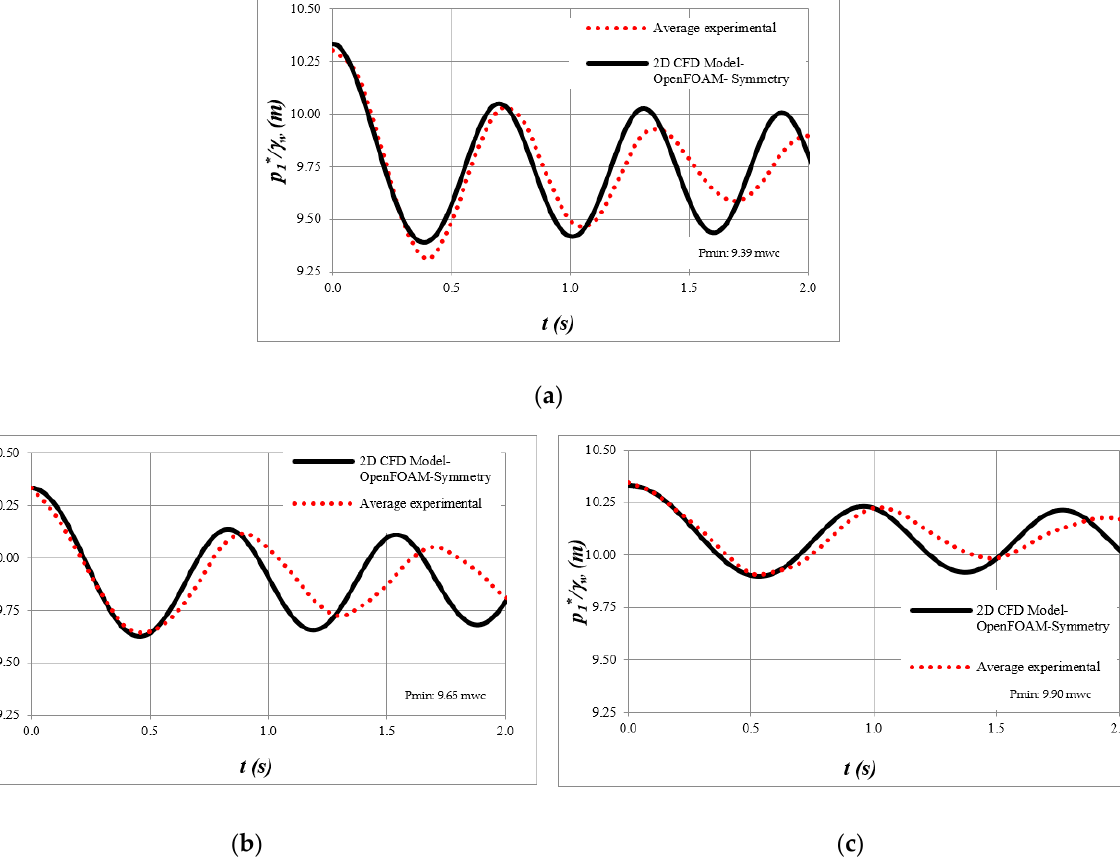
Figure 5. Comparison of pressure patterns between the experimental model and the 2D CFD OpenFOAM symmetry model for cases B: ( a ) run B4; ( b ) run B5; ( c ) run